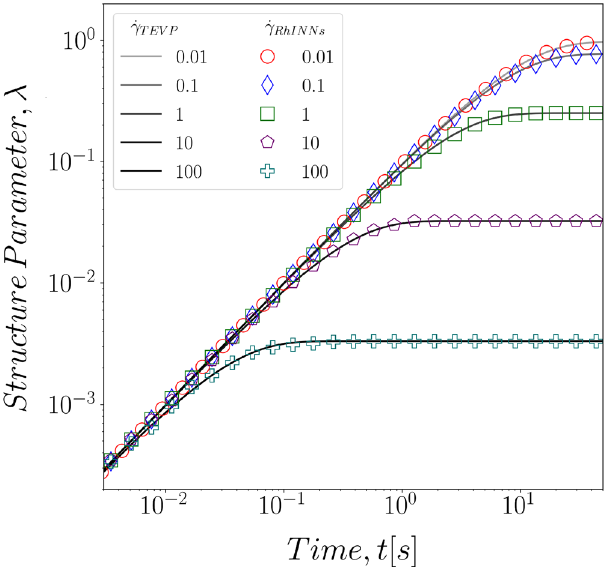
Figure 7. RhINNs predictions of the time evolution for structure parameter based on values of the time constants learned in one set of simple shear experiment. Here G = 800 [ Pa ] , σ y = 20 [ Pa ] , η s = 20 [ Pa s ] , and η p = 20 [ Pa s ] are known from the material properties.